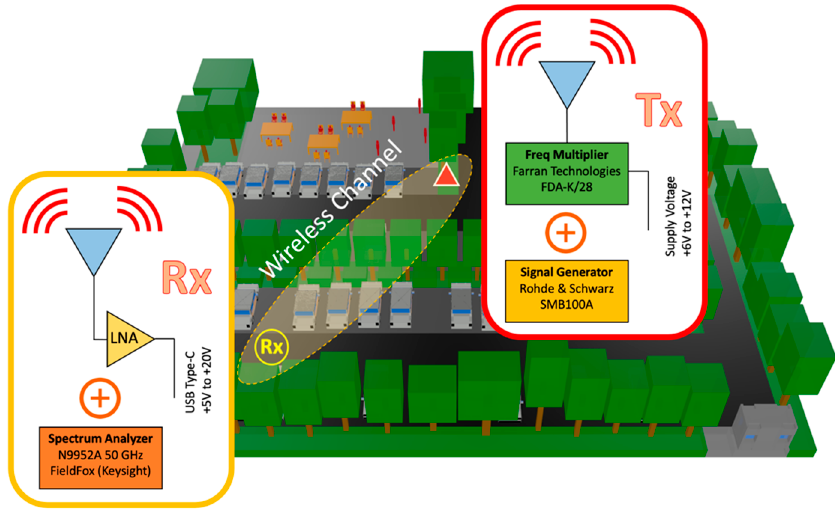
Figure 3. Schematic scenery of the experimental setup in the considered outdoor parking lot.